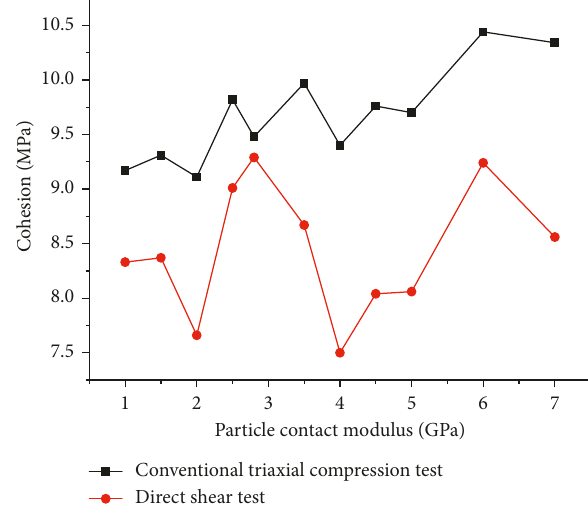
Figure 6: Influence of particle contact modulus on